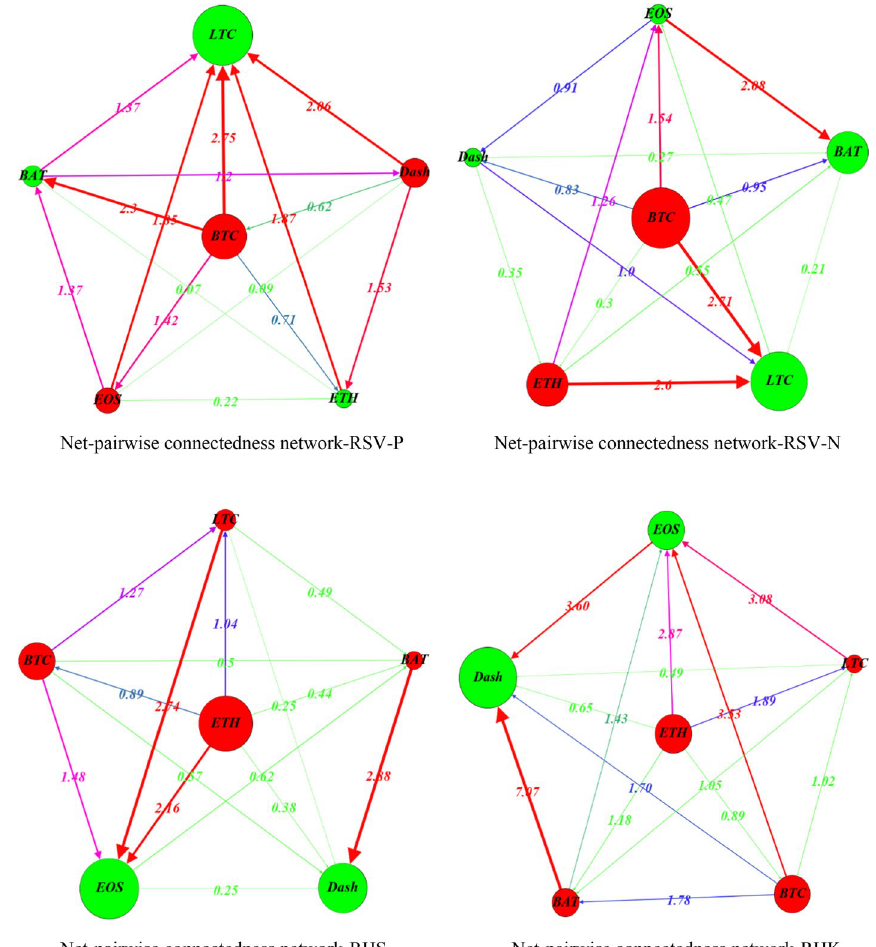
Fig. 21 Directional net-pairwise connectedness networks